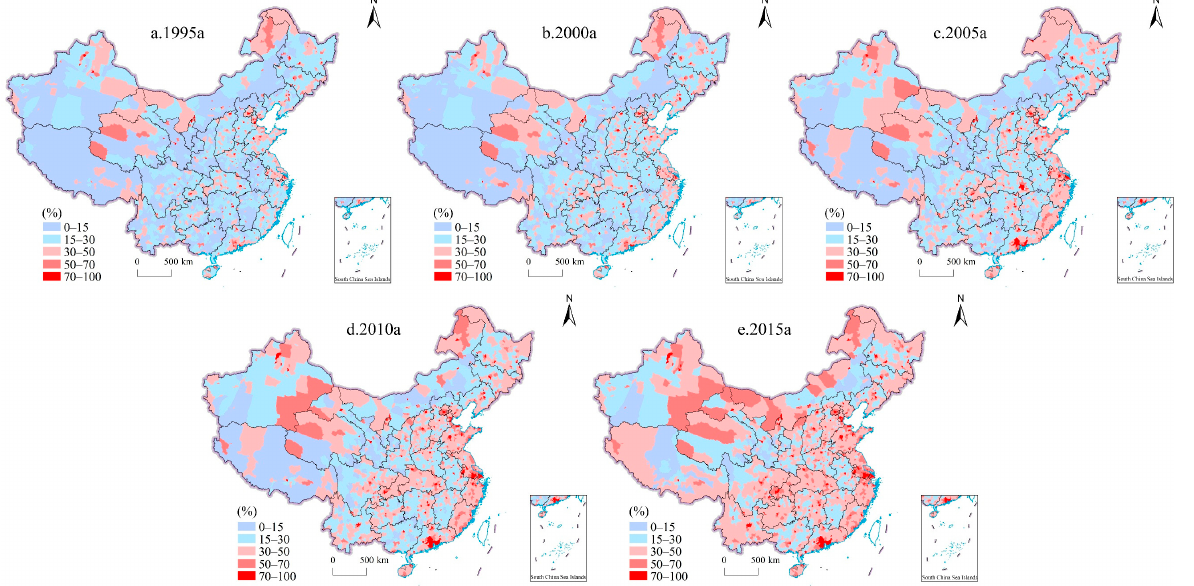
Figure 2. Spatial distribution of comprehensive urbanization rate of China’s counties from 1995 to 2015. In 1995, the overall comprehensive urbanization rate of counties in China was low. The average urbanization rate of 2851 counties was 31.06%, with obvious regional